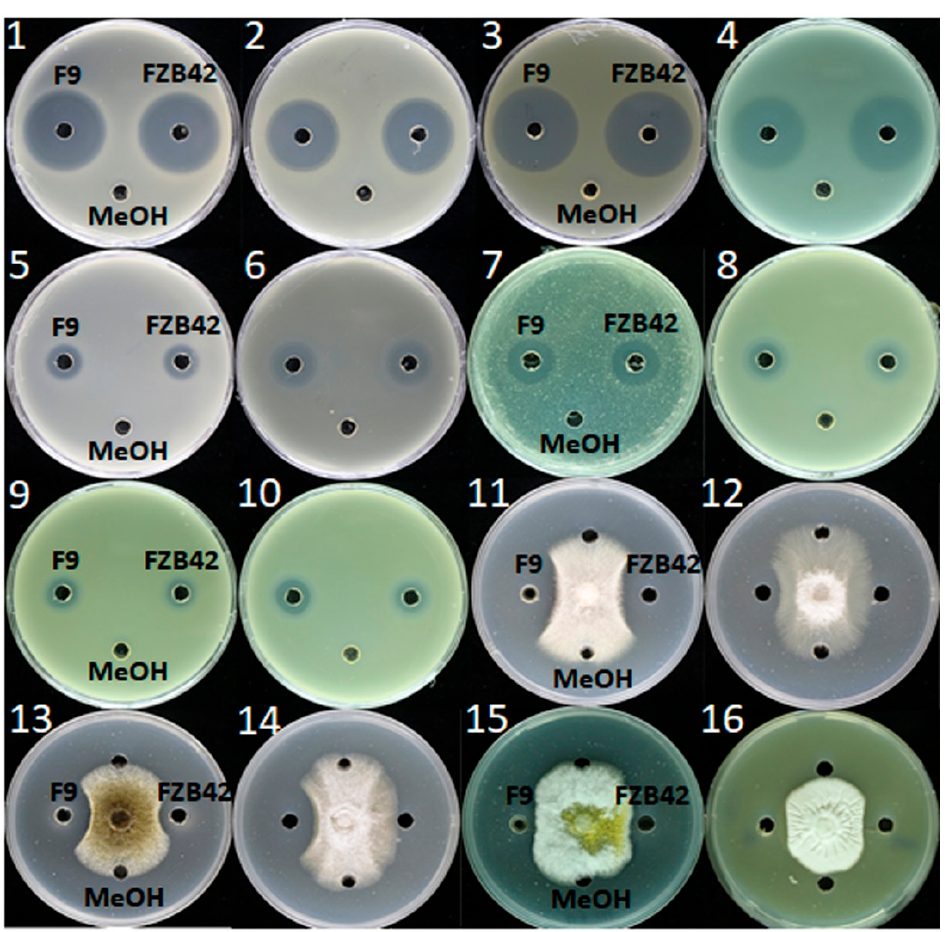
Figure 5. Demonstration of the inhibitory effects of F9LE against 16 phytopathogenic bacteria and fungi (panels 1–16). (1) X. citri subsp . citri strain jx-6, (2) X. campestris pv. campestris strain XC1, (3)